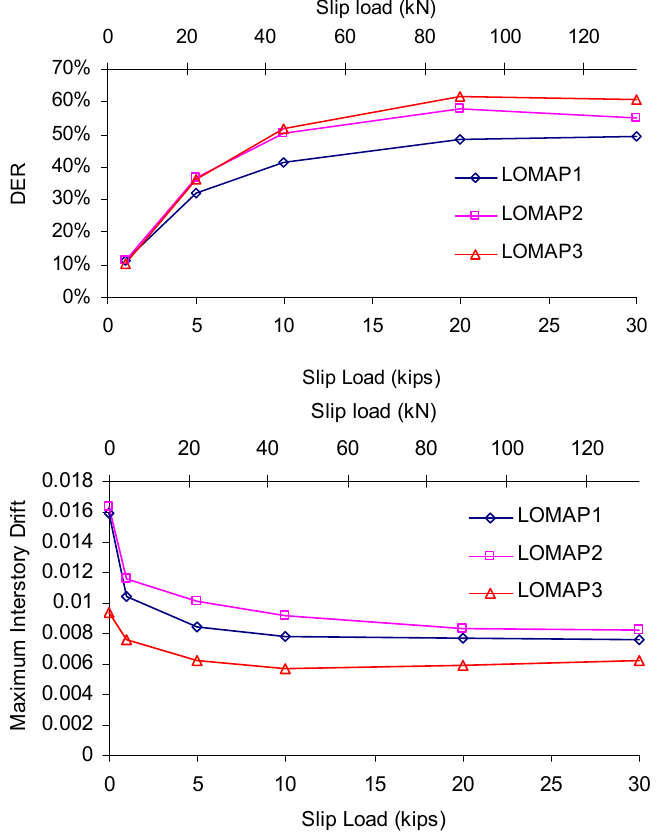
Figure 11. Variation of energy dissipation and maximum interstory drift with slip